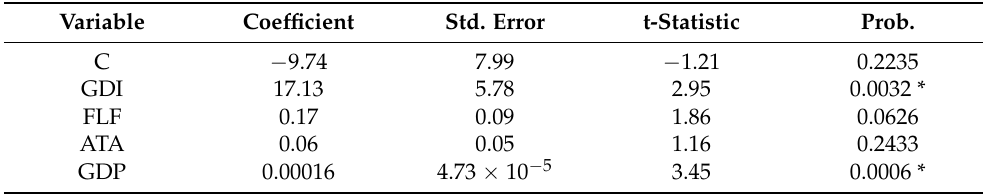
Table 4. Regression